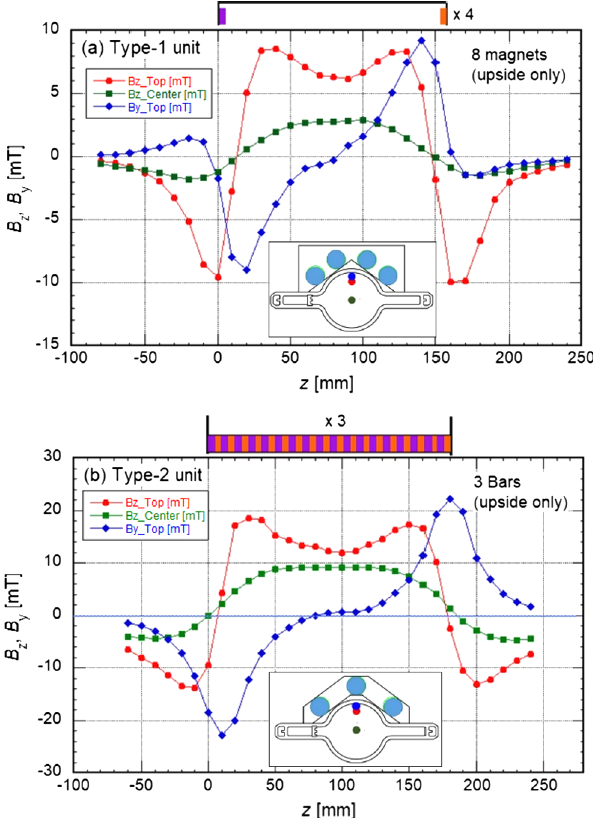
FIG. 7. Axial distributions of the measured vertical and axial components of the magnetic field ( B y and B z ) at the top surface, and B z at the center of the beam channel in (a) type-1 and (b) type-2 unit.